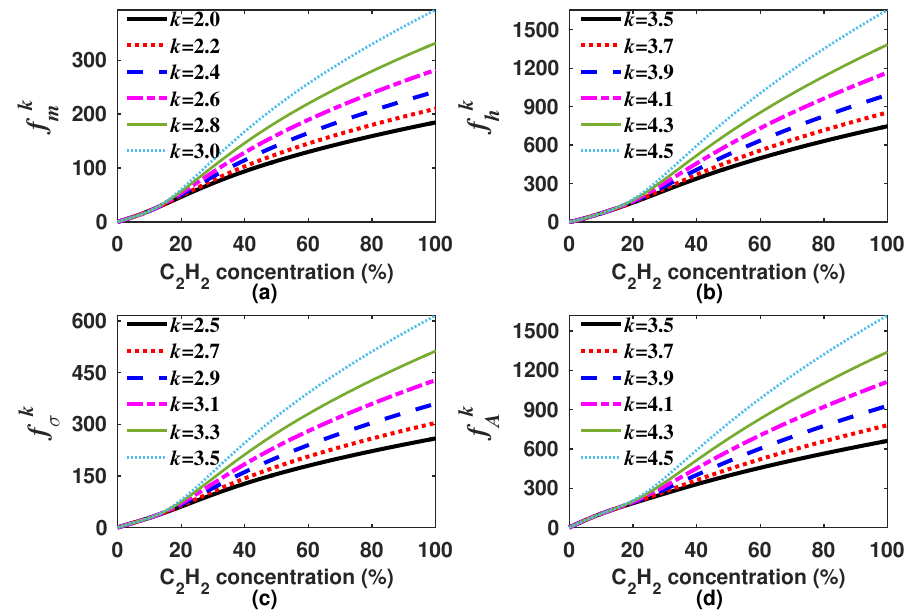
Figure 7. Generating functions ( a ) f k m ; ( b ) f k interval of k values that generate functions with a quasi-linear behavior.